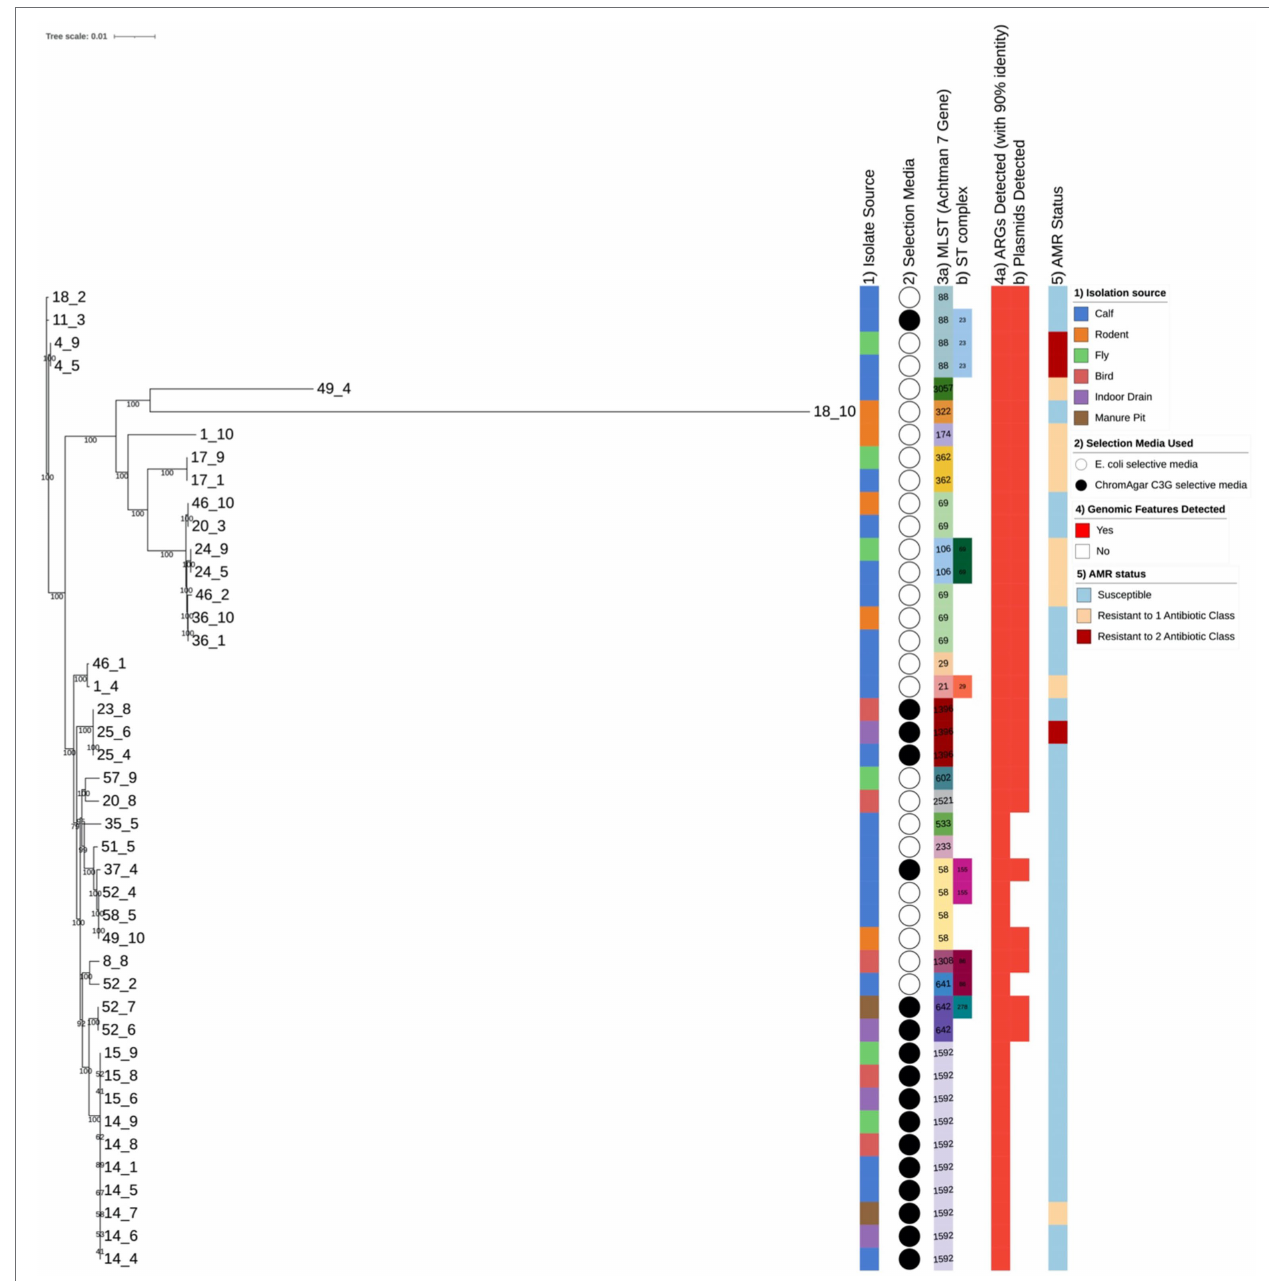
FIGURE 1 | Maximum Likelihood phylogenetic tree of the bacterial isolates of this study. The tree includes all isolates sequenced named by farm of origin followed by sample source type. It was constructed using core genome of each isolate with 100 bootstrap replicates with values on the tree and the corresponding metadata of (1) isolate sample source according to key, (2) isolate selection media used according to key, (3) isolate genomic typing (3a) multi-locus sequencing typing using Achtman 7 gene scheme and (3b) detection of sequence type clonal complexes, (4) genomic features in the E. coli isolates (4a) detection of antimicrobial resistance genes (4b) detection of plasmid replicons according to key, (5) the E. coli isolates phenotypic AMR status to tested drugs according to